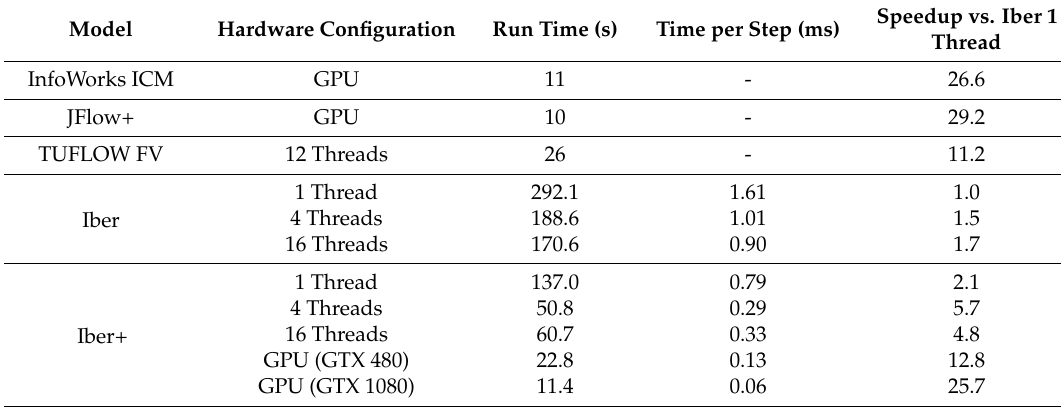
Table 3. Performance measurements for Test 2. Total run time of the simulation in seconds, average processing time per time step in milliseconds and the achieved speedups compared with Iber running in a single thread.